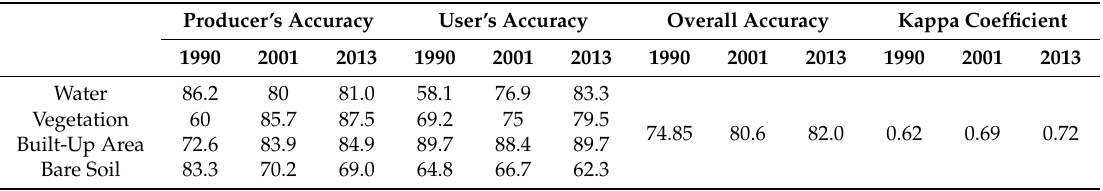
Table 3. Summary of the error matrices for the 1990, 2001, and 2013 using the maximum likelihood classification method.